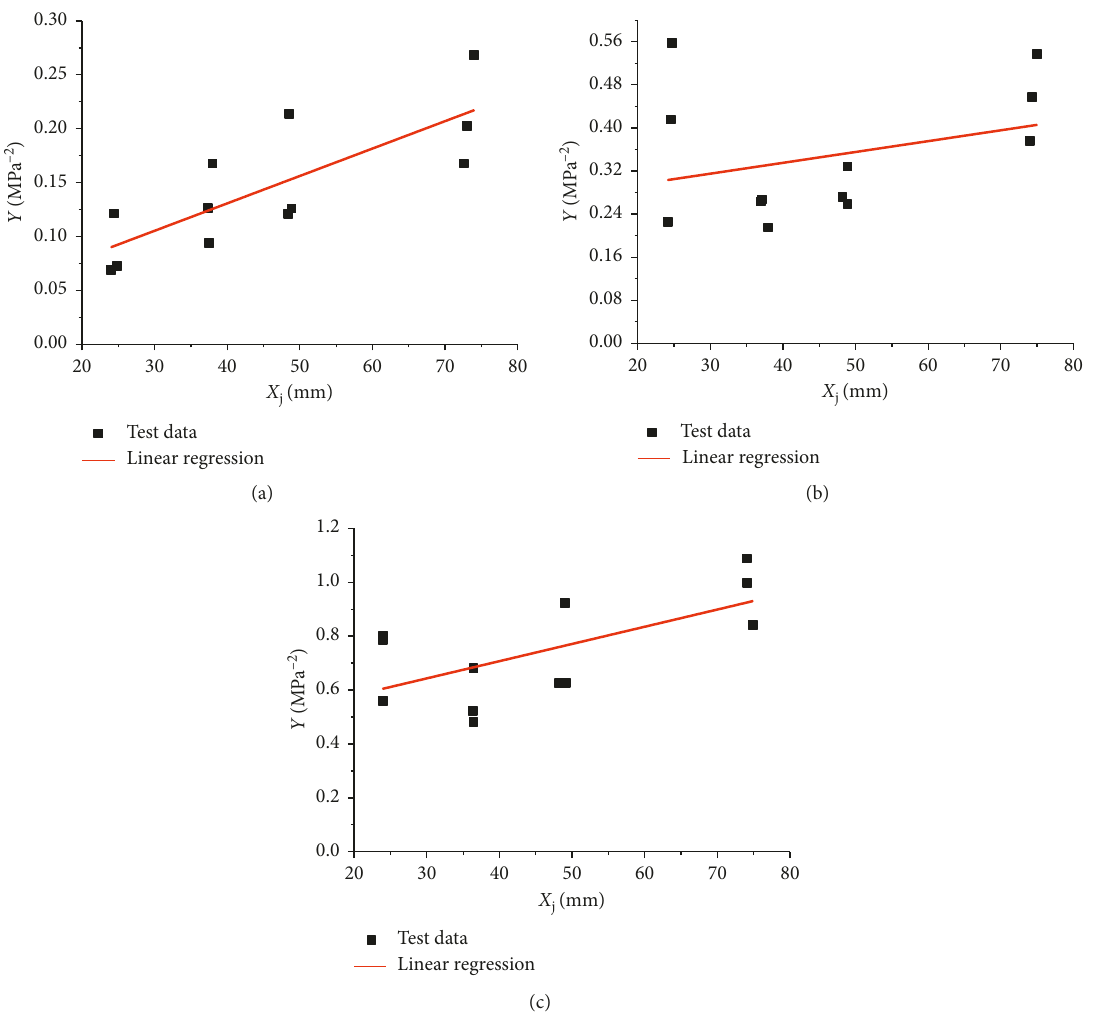
Figure 5: Test regression curve. (a) α � 0.4. (b) α � 0.5. (c) α �